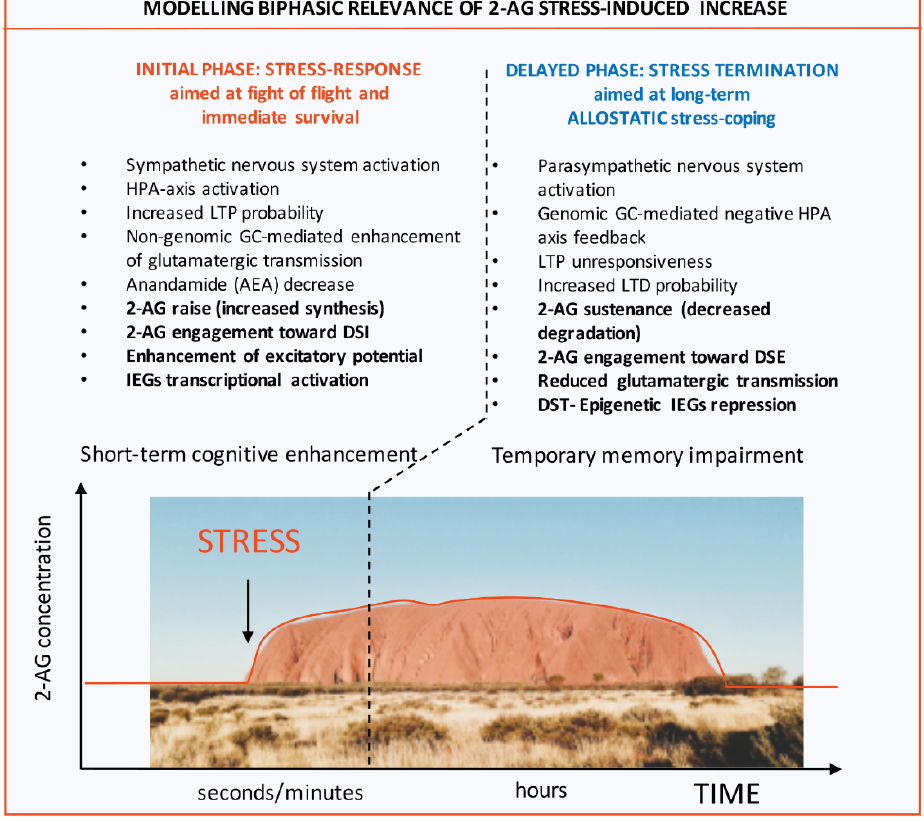
Figure 1. Modelling Biphasic relevance of 2-AG stress-induced increase and its epigenetic allostatic regulation as instrumental to stress response termination: An Ayer(s) perspective. The figure illustrates molecular and behavioral events occurring immediately upon stress perception (INITIAL PHASE) and in second phase in which primary responses, aimed at guaranteeing survival are gradually terminated (DELAYED PHASE). While in the first phase of stress response, which lasts seconds to minutes, cognition is boosted via neuroendocrine enhancement of glutamatergic transmission (short-term cognitive enhancement), in the second phase mechanisms underlying arousal as well as memory consolidation of the traumatic event are allostatically tuned down (resulting in a temporary memory impairment). Within this model, while in the first phase, endocannabinoid 2-AG increases its levels thanks to de novo synthesis by DAGL α , being involved in enhancing excitatory potential via Depolarization-Induced Suppression of Inhibition (DSI), in the second phase its tone is maintained elevated by an epigenetic process aimed at repressing transcription of the two 2-AG hydrolases MAGL and ABHD6. Thus, 2-AG displays a prototypic biphasic behavior. Notably, in this second window of stress response 2-AG is involved in decreasing glutamatergic transmission within the opposite form of endocannabinoid-operated short-term plasticity i.e. the process of Depolarization-Induced Suppression of Excitation (DSE). The graph displays enduring 2-AG stress-induced raise that lasts over both stress-response phases. The picture displays Ayers Rock (Uluru), Australia. Abbreviations used: 2-AG: 2-arachidonylglycerol; DAGL α :